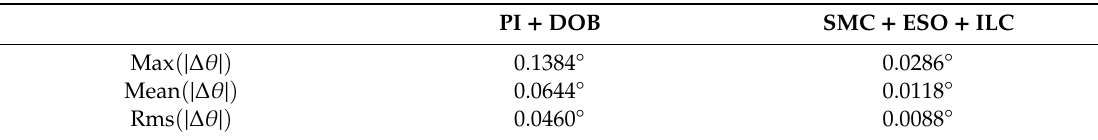
Table 6. Position pointing error of sine wave